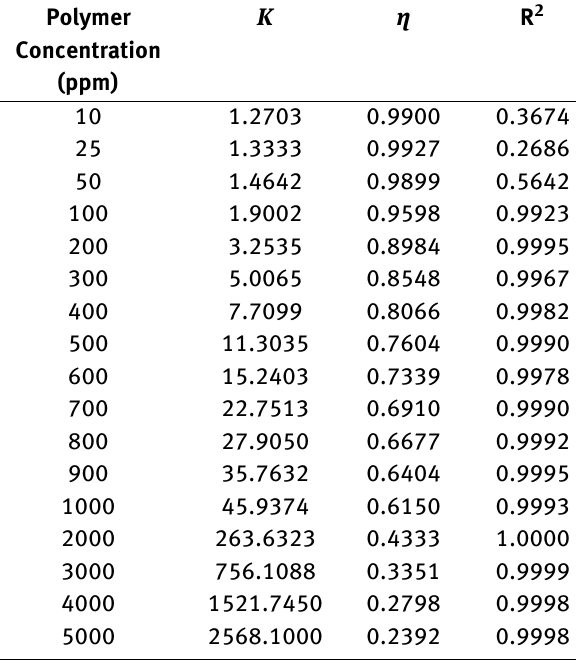
Table 4: Fit parameters to the Power Law Model for 23 ∘ C/110,000 ppm NaCl